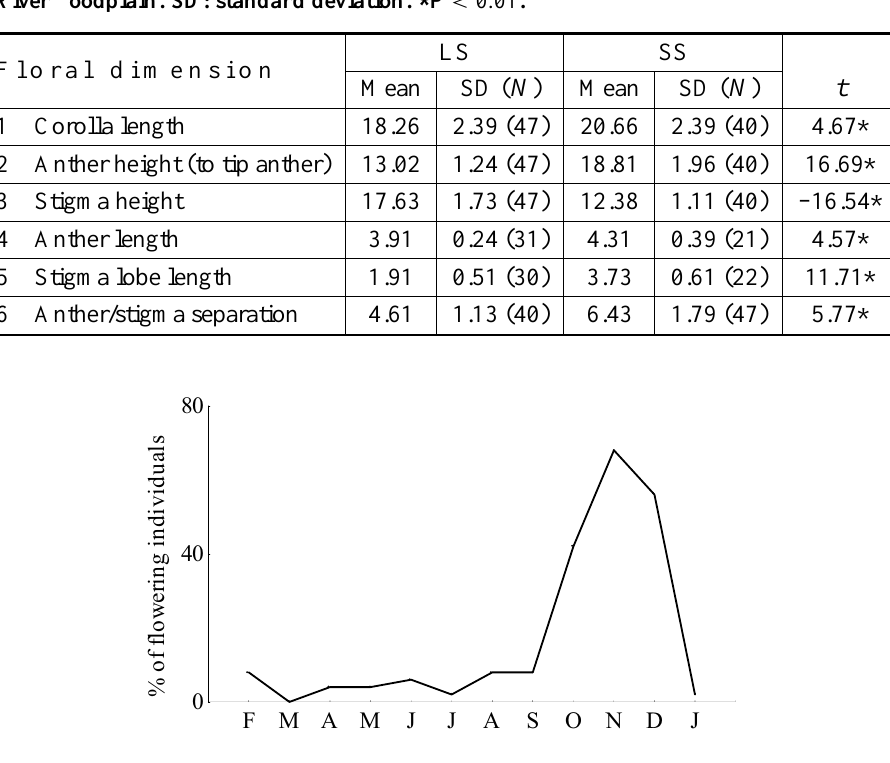
Fig. 2 – Flowering phenology of Palicourea crocea (percent of individuals with flowers, N = 50) in the Upper Paraná River floodplain,